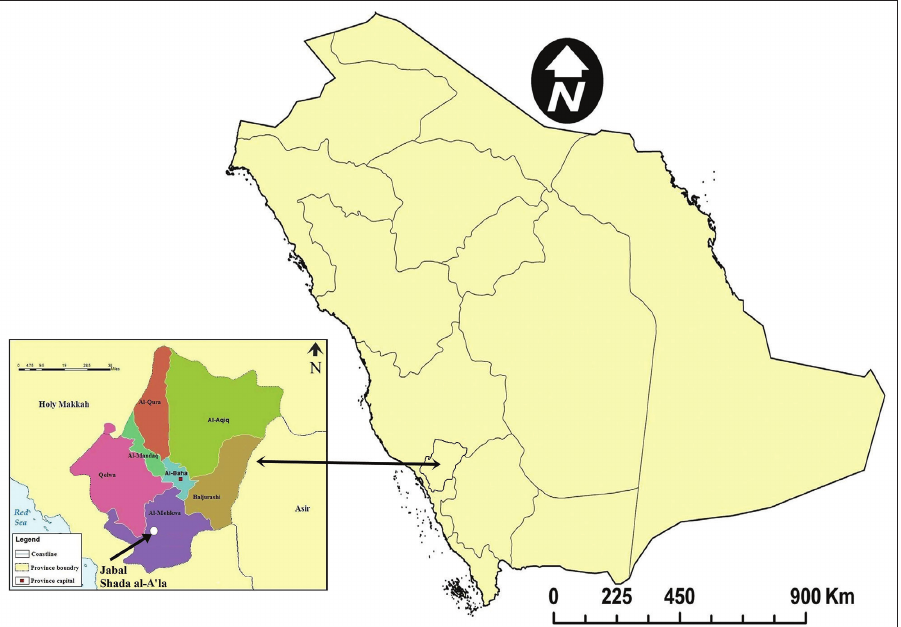
Figure 1. Map of Saudi Arabia showing Al-Baha Province and Jabal Shada al-A‘la Nature Reserve.